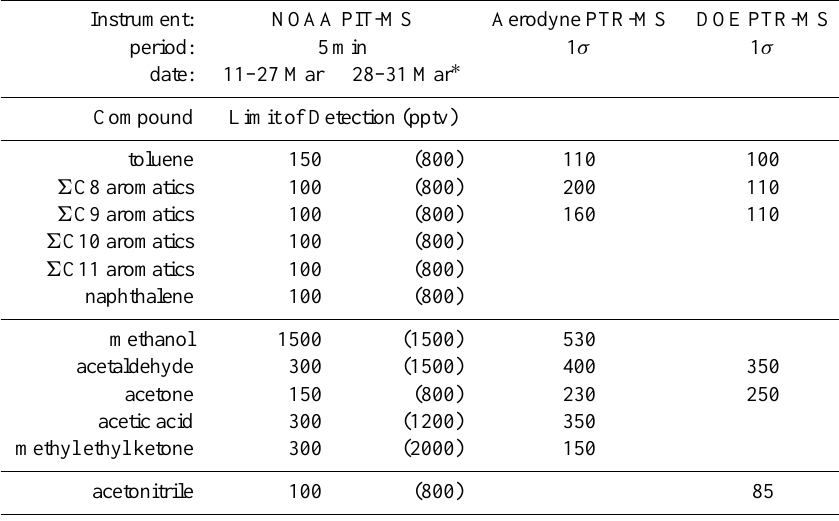
Table 1. Limits of detection for individual VOCs quantified during the MILAGRO campaign by PIT-MS and PTR-MS.